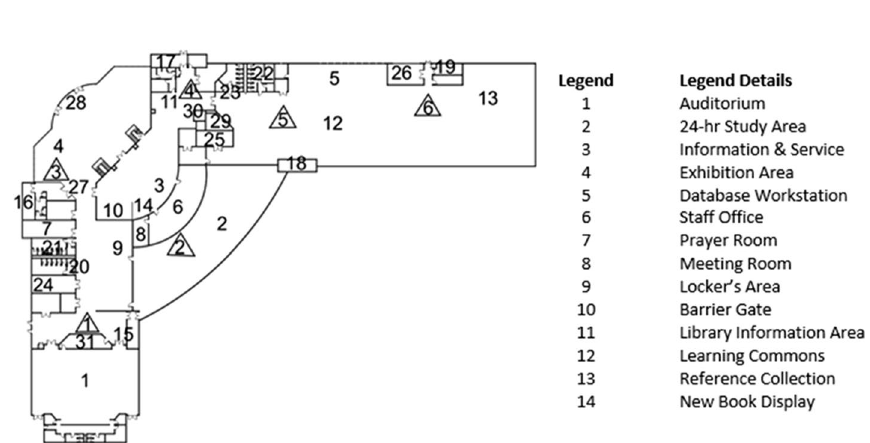
Fig. 6 Sample of building layout and gateway